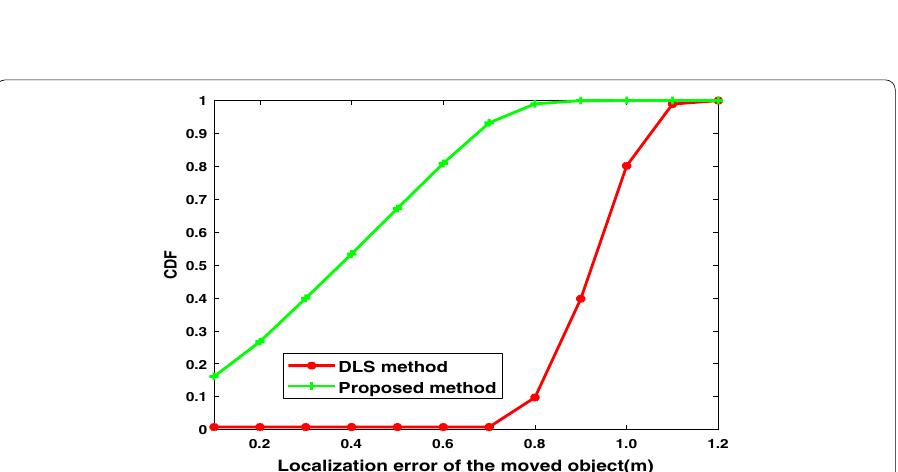
Fig. 8 Localization error comparison by different visual fingerprint relocation method when there is one displaced